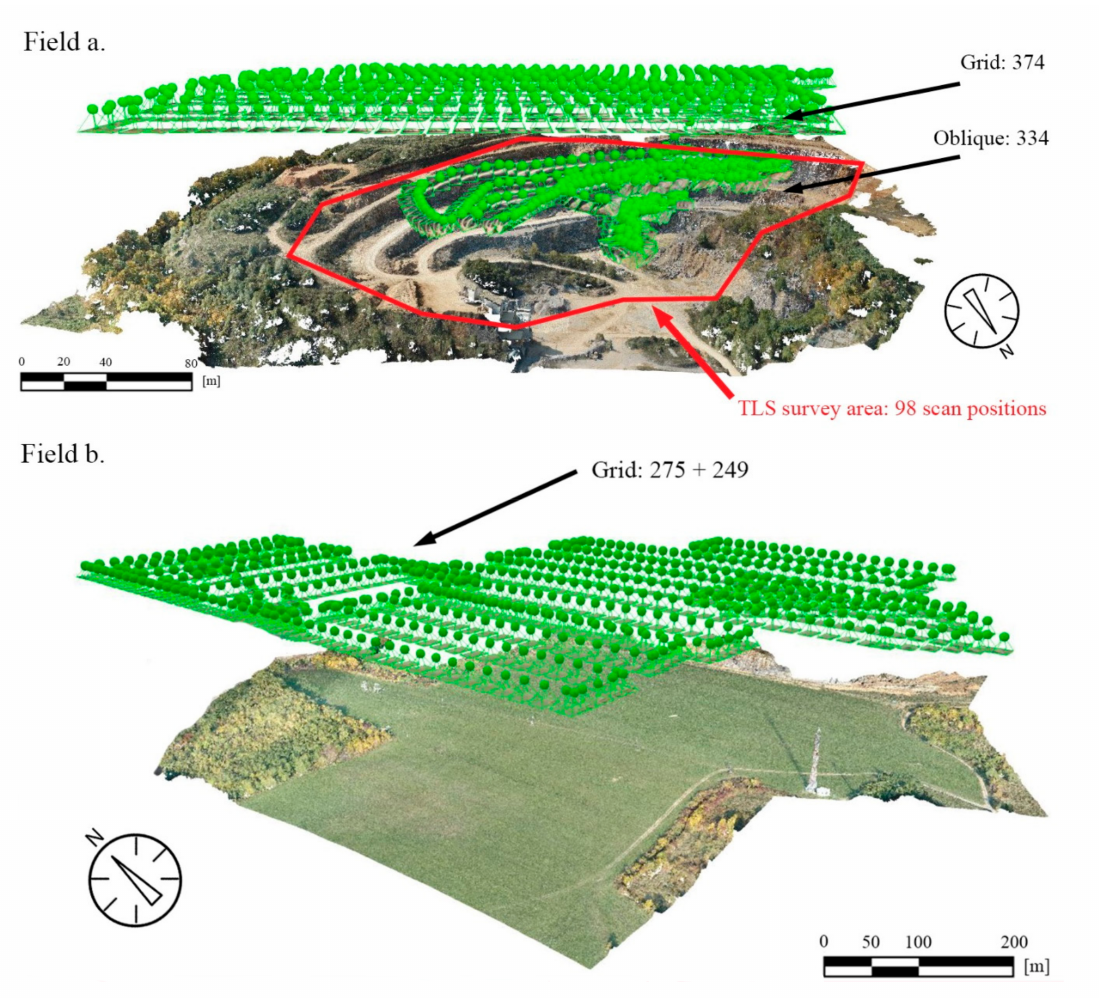
Figure 5. UAV image locations with numbers of grid plus oblique images and TLS survey area at the quarry: ‘Field a’ ( top ); UAV image locations and number of grid images at the plateau: ‘Field b’( bottom